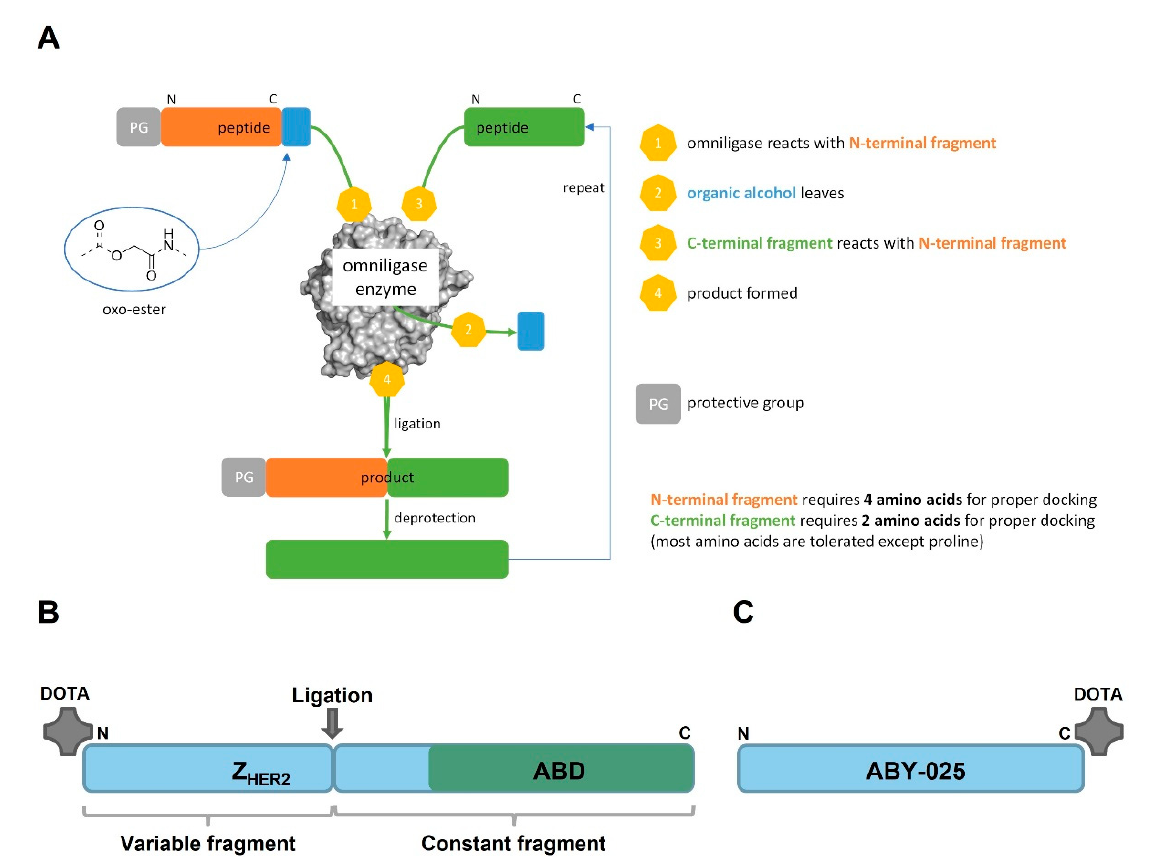
Figure 1. ( A ) Overview of the Chemo-Enzymatic Peptide Synthesis (CEPS) method. Smaller peptide fragments are synthesized separately and subsequently joined by Omniligase. The detailed reaction scheme can be found in Supplementary Figure S1. ( B ) Schematic of PEP40233 produced by CEPS linking a variable fragment that is interchangeable for different binding specificities (here HER2) and a constant fragment comprising an ABD moiety for half-life extension. A chelating DOTA moiety may optionally be incorporated at the N-terminus during the chemical synthesis. ( C ) Schematic of the HER2 targeted Affibody molecule ABY-025 with a DOTA moiety conjugated at the